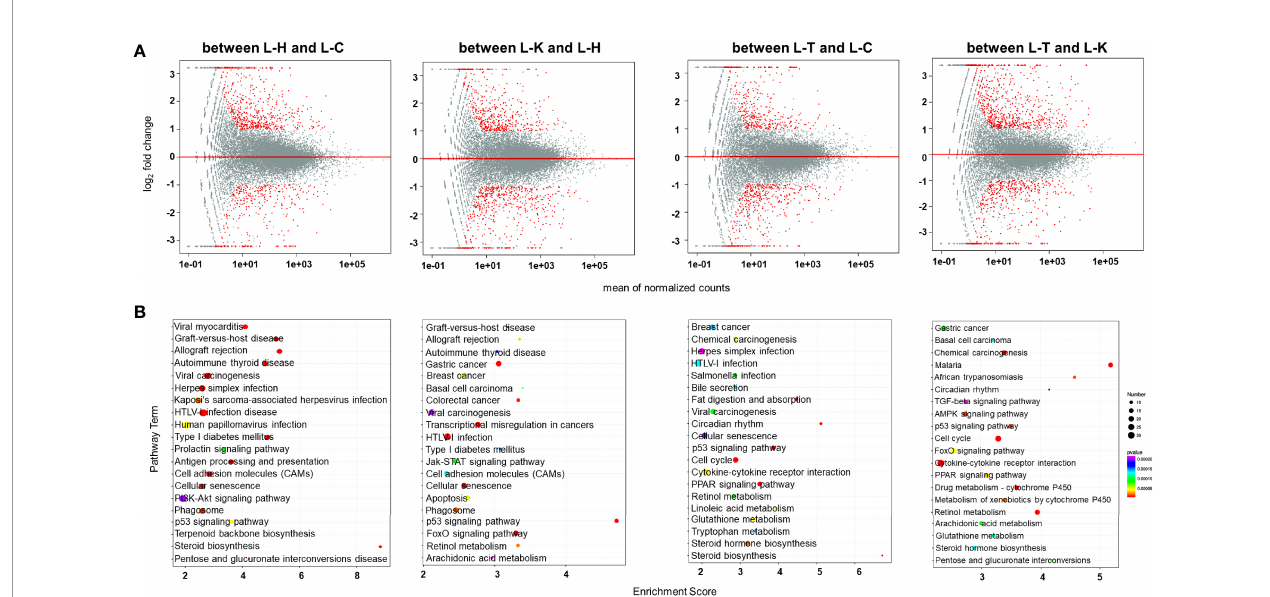
FIGURE 8 | Transcriptomic analysis of the rat livers. (A) MA (M-versus-A) plots showing differential expressing genes in rat livers between the four rat groups including healthy control rats (L-H) (n=6), CIA rats (L-C) (n=6), CIA rats treated with 2-DG (L-T) (n=6), and healthy rats treated with 2-DG (L-K) (n=6). (B) Bubble charts showing the top 20 differentially enriched pathways in the rat liver among the four rat